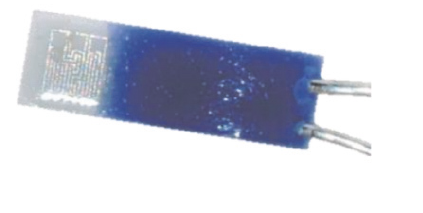
Figure 2: Tsensor: RTD HERAEUS (cid:3) M222 Pt1000 (patient side).